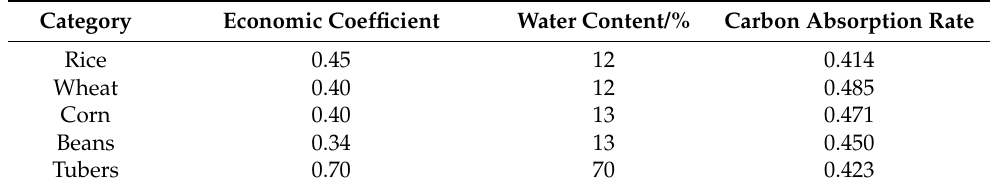
Table 1. Economic coefficients, water content, and carbon absorption rates of major food crops in China.